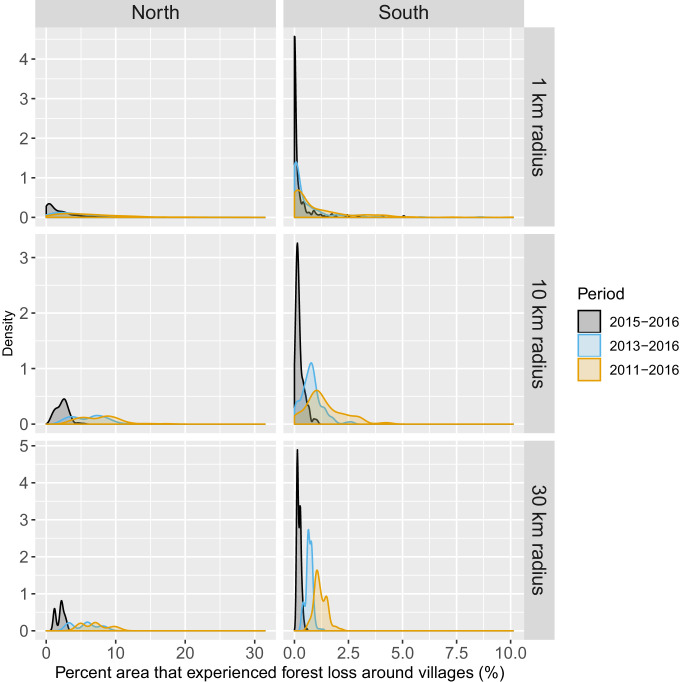
Distribution of percent area within 1, 10, and 30 km of villages that experienced forest loss between 2011 and 2016.Note that the scales are different for every panel for better visualization of the distributions.